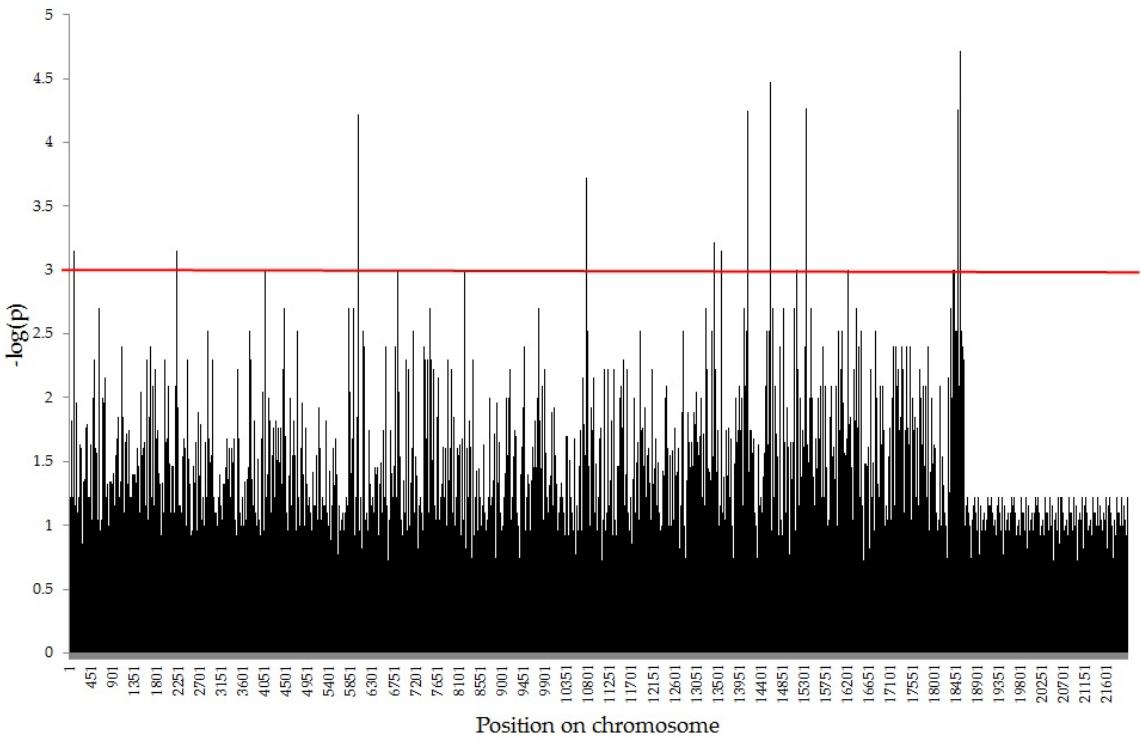
Figure 1. Manhattan plots for seed vigor. Table 1. Molecular markers of SilicoDArT and SNP significantly (LOD > 3.0) related to the seed vigor and seed germination (significant associations selected at p < 0.05 with correction for multiple testing using the Benjamini–Hochberg method). Table contains the number of significant markers associated with each particular trait, range of significant effects (minimal and maximal effects), mean value of all significant effects, and percentage variance accounted by significant markers (minimal, maximal, and mean values).